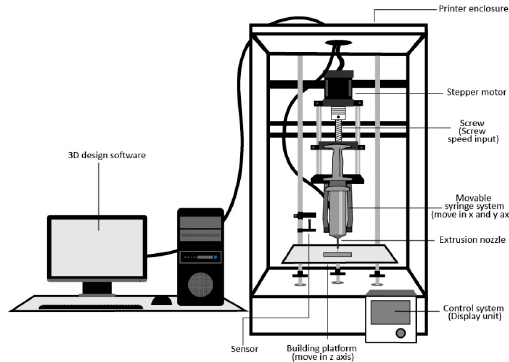
Figure 1. Schematic diagram of syringe extrusion 3D printer.